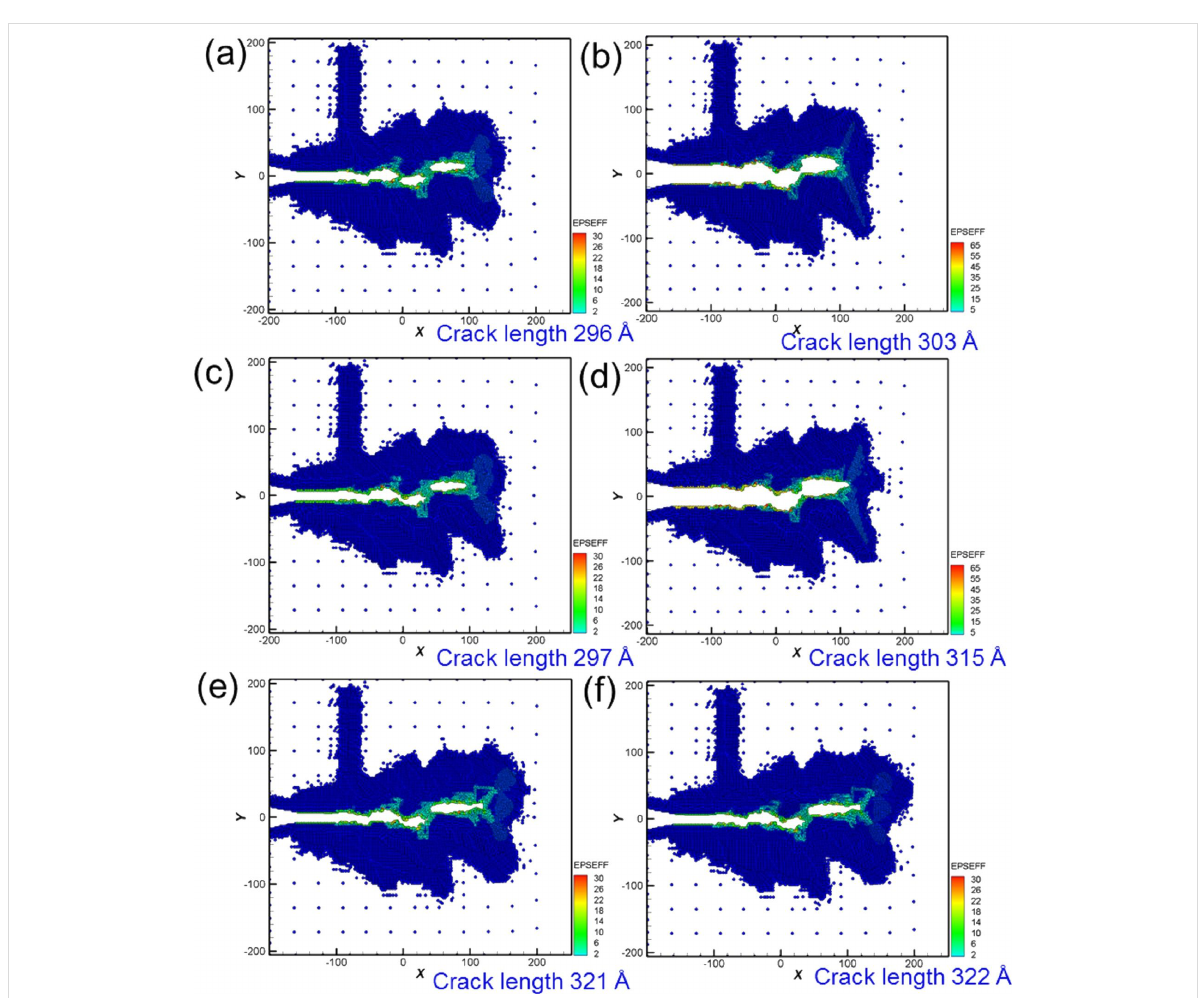
Figure 11: Crack growth and expansion diagrams of Fe corresponding to the observation positons a–f annotated in Figure 10.